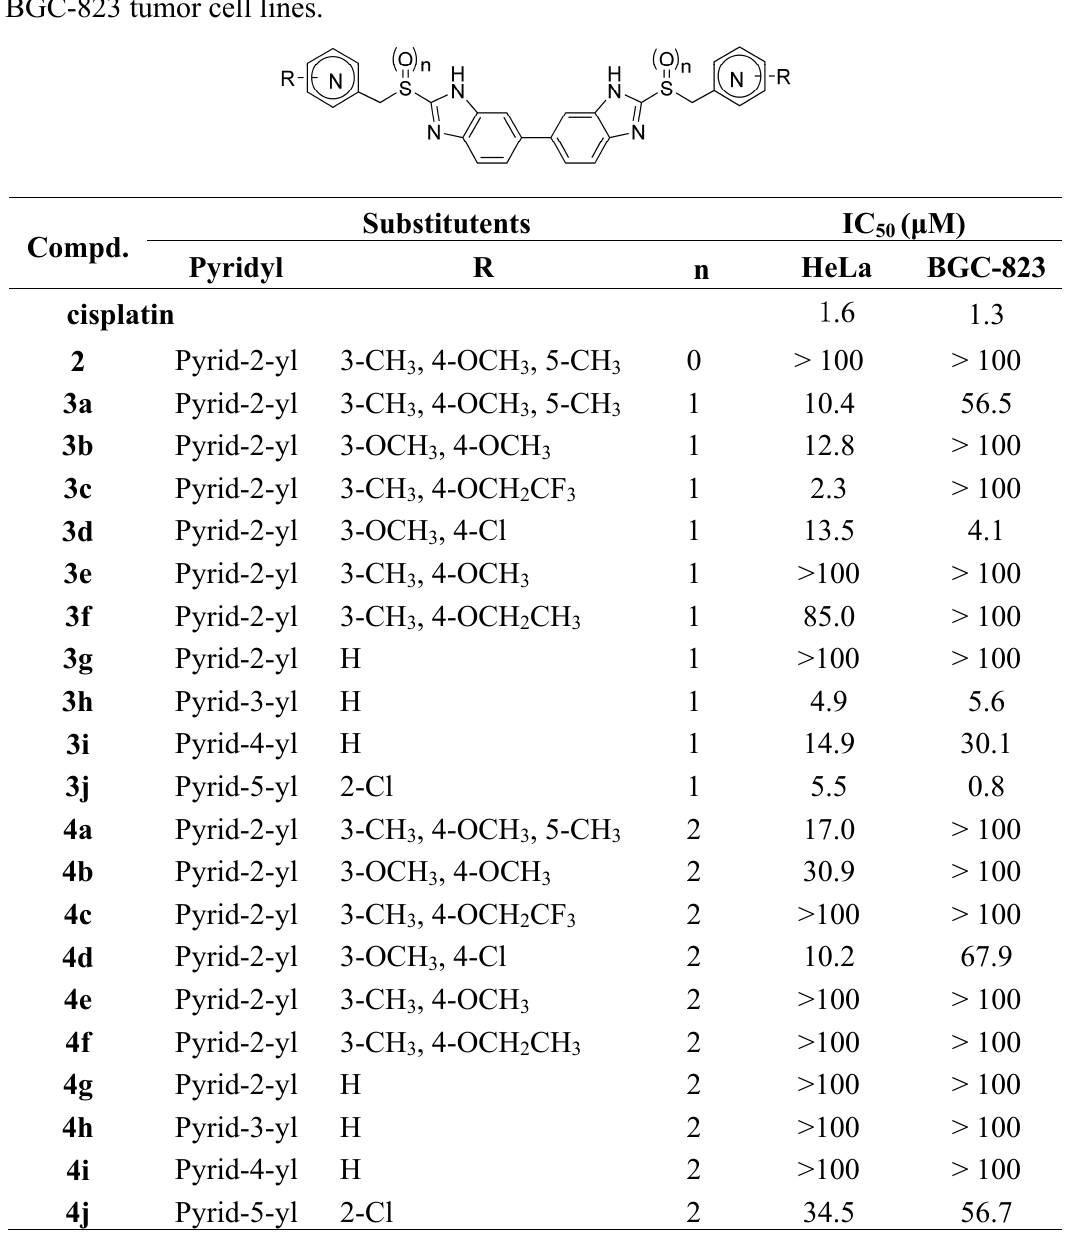
Table 1 . Structure and anti-tumor activity of dimeric PPI analogues against HeLa and BGC-823 tumor cell